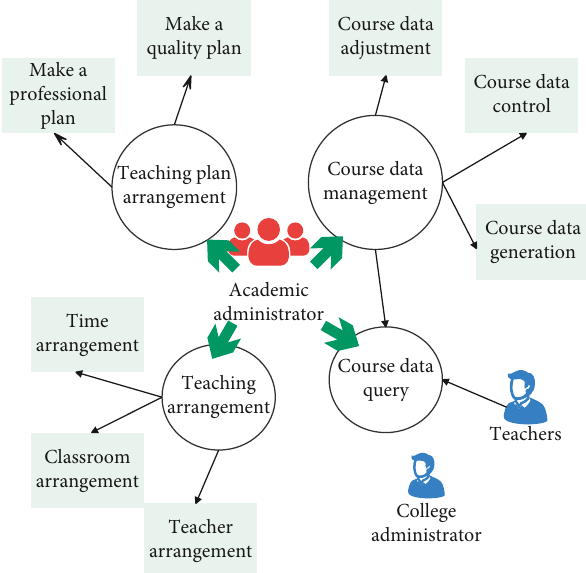
Figure 7: Use case diagram of course management